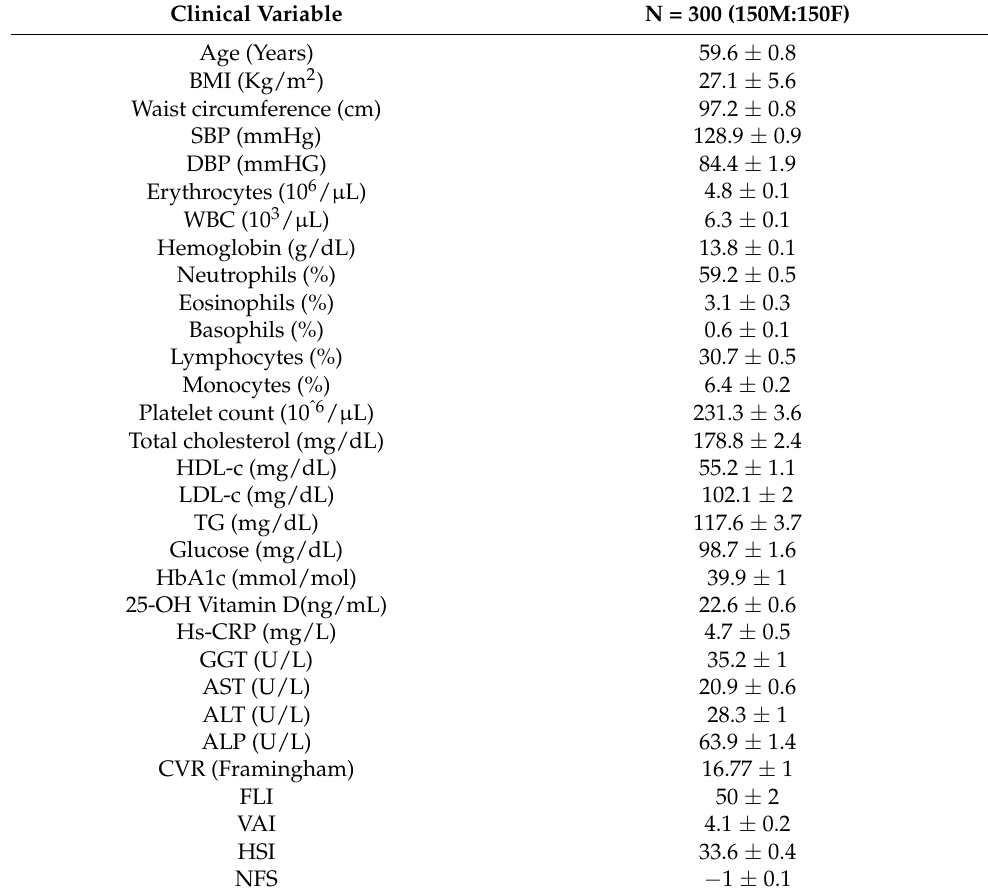
Table 1. Clinical characterization of the study population.